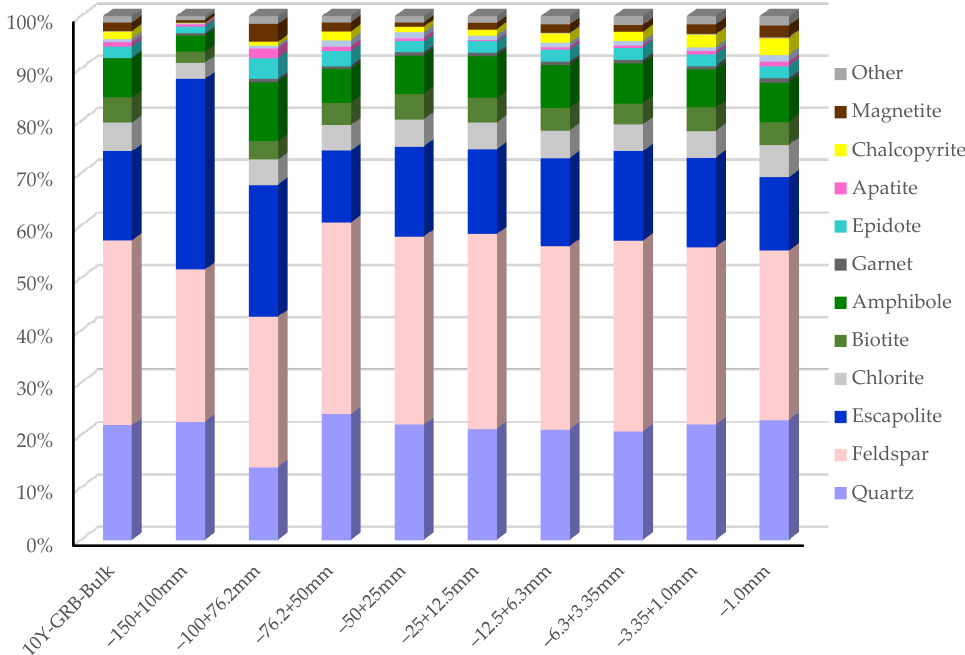
Figure 7. Mineralogical modal composition (wt.) of size fractions of 10Y-GRB sample and comparison to the bulk sample.